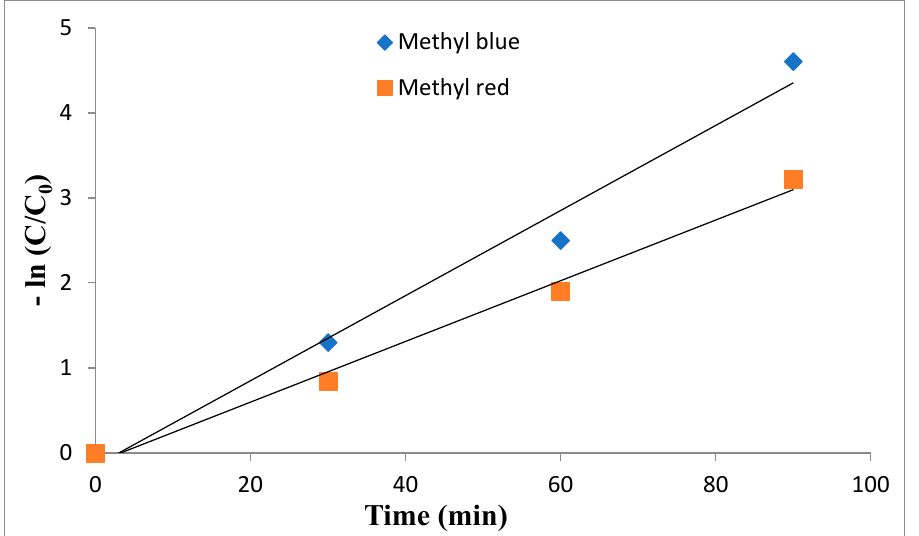
Figure 10. Pseudo first-order kinetics of photocatalytic degradation of dyes by solar/CS-NM photocatalysis.